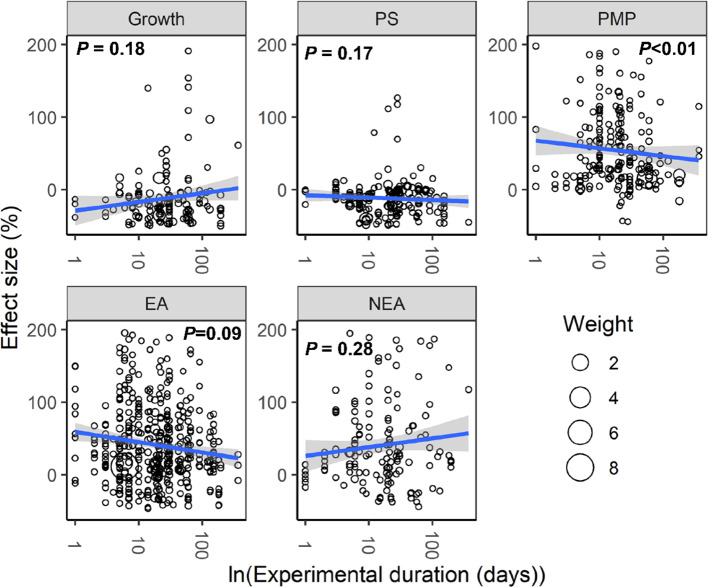
Responses of plant performances to experimental duration. Linear regressions (blue lines) and their 95% confidence intervals (shaded areas) and corresponding levels of significances (P values) are presented. Circle sizes are proportional to the sampling variances. See 
Figure 2
 for abbreviations.